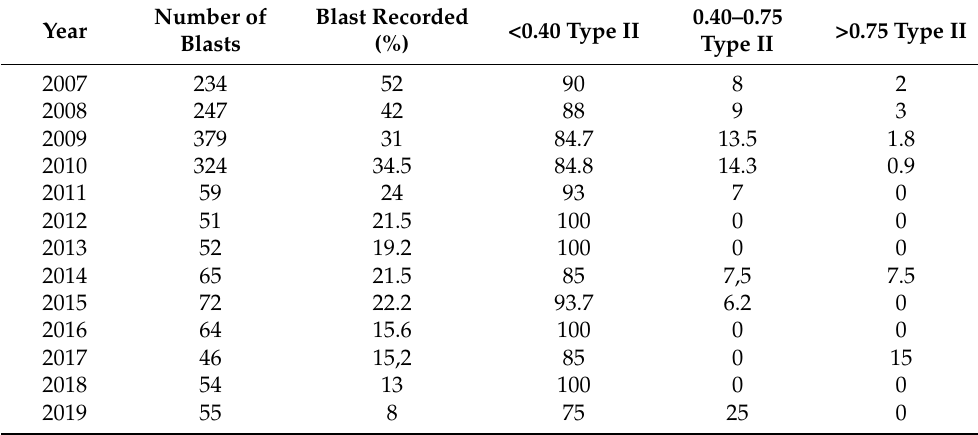
Table 5. Characteristics of the